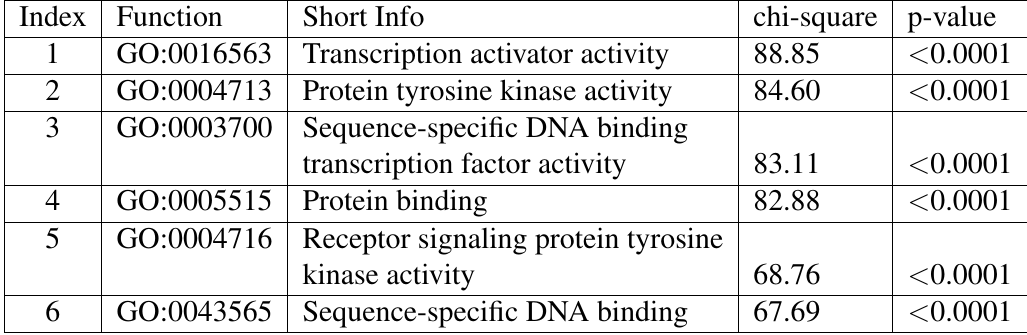
Table 4: Most discriminative functions from Molecular Function based on FS method.